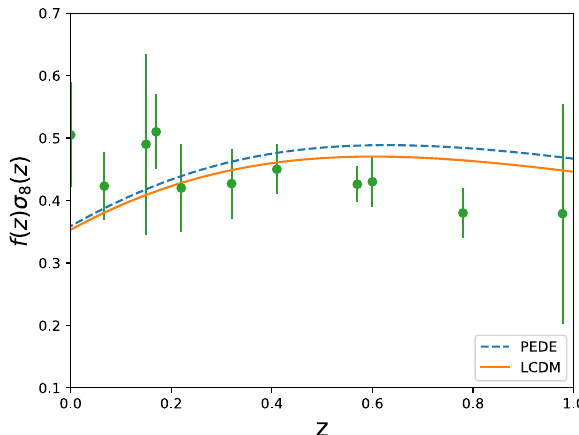
Fig. 2 The redshift evolution of H ( z )/( 1 + z ) for PEDE and (cid:2) CDM and related observational data points. We set (cid:4) m , 0 and H 0 upon on their best values in last columns of Tables 2 and 3, respectively, for PEDE and (cid:2) CDM cosmologies